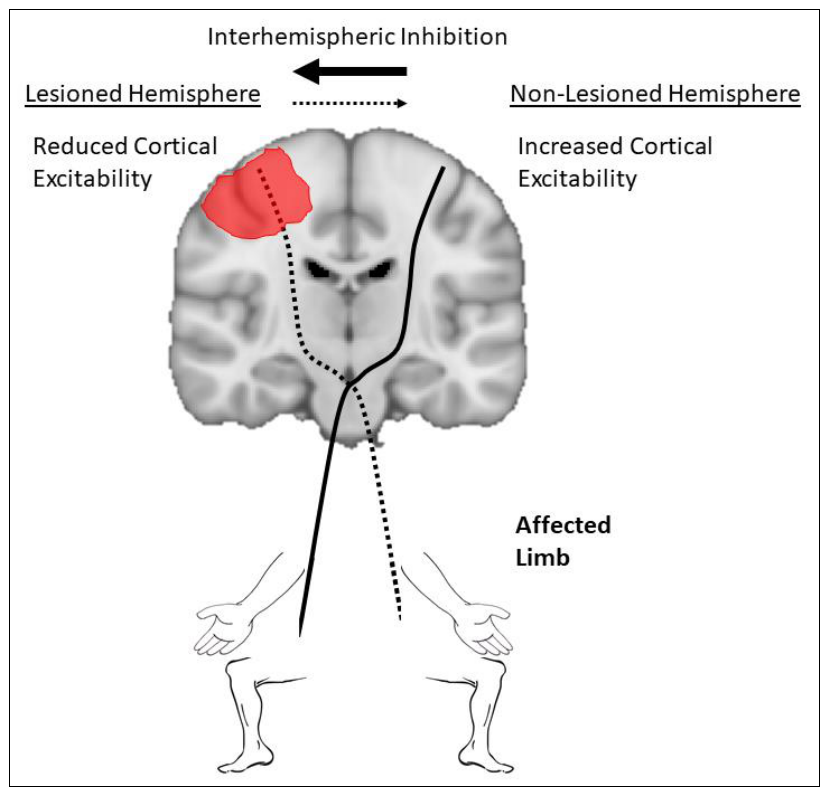
Figure 2. The interhemispheric imbalance model is commonly used to apply transcranial direct current stimulation. The lesion is shown in red within the cortex. Note that excitability of the lesioned hemisphere is reduced, leading to a decrease in excitability of descending and interhemispheric pathways (shown as a dotted line). Interhemispheric inhibition is imbalanced between hemispheres, shown as a dotted line for reduced interhemispheric inhibition at the top of the image, and a thick solid line for increased interhemispheric inhibition. This imbalance in interhemispheric inhibition further suppresses excitability of the lesioned hemisphere.